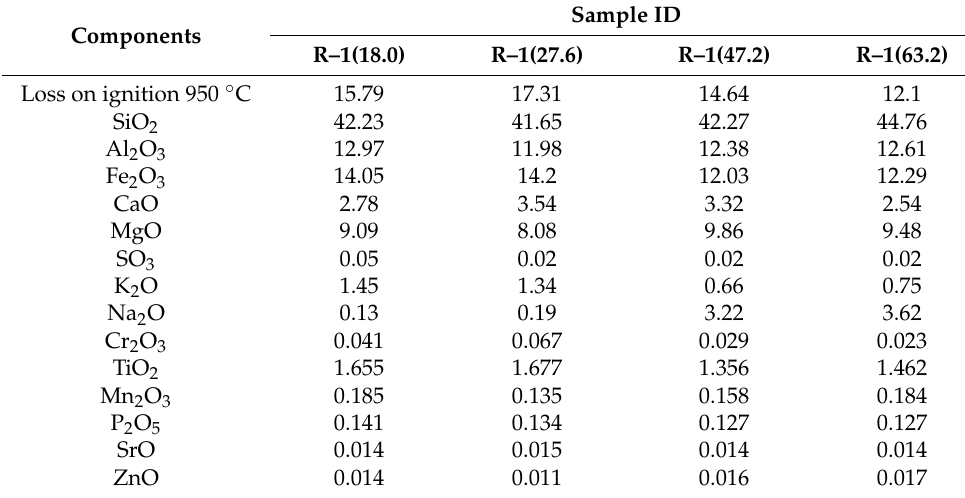
Table 3. Chemical composition of volcanic tuff core samples from Radoshivka–1 well (% w / w